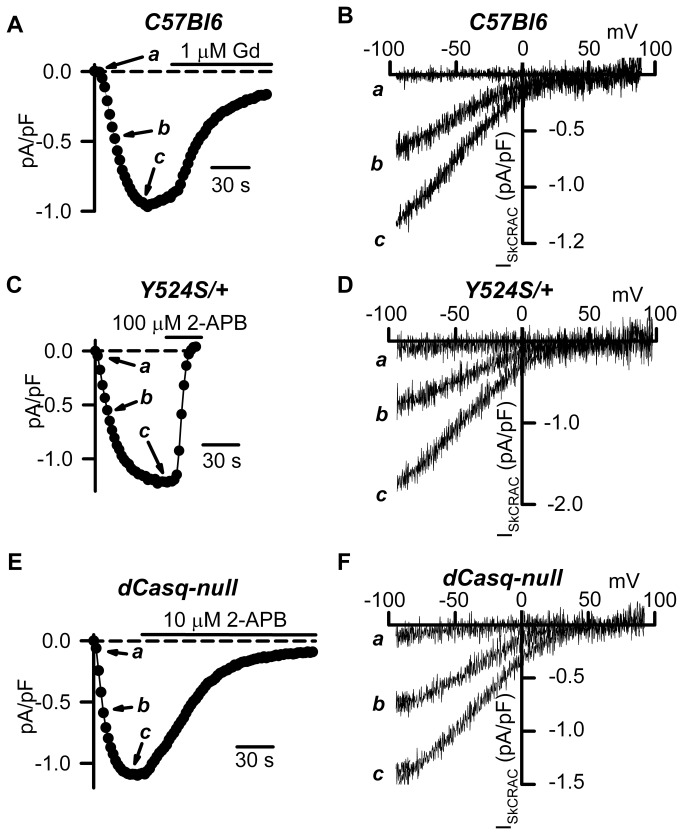
ISkCRAC properties in myotubes from Y524S/+ and dCasq-null mice.(A, C, and E) Representative time courses for ISkCRAC activation during repetitive ramp depolarization in the presence of 20 mM internal EGTA in myotubes from WT C57Bl6 (A), Y524S/+ (C), and dCasq-null (E) mice. ISkCRAC was measured at -80 mV and plotted against time. Following full activation, ISkCRAC was blocked by addition of either 1 µM Gd2+ (A), 100 µM 2-APB (C), or 10 µM 2-APB (E). Arrows indicate time points a, b, and c used to illustrate ISkCRAC voltage dependence in panels B, D and F. Dashed lines represent the zero current level and solid lines indicate drug application. (B, D, and F) Voltage dependence of ISkCRAC for the representative WT C57Bl6 (B), dCasq-null (D), and Y524S/+ (F) myotubes shown in A
C, and E, respectively.